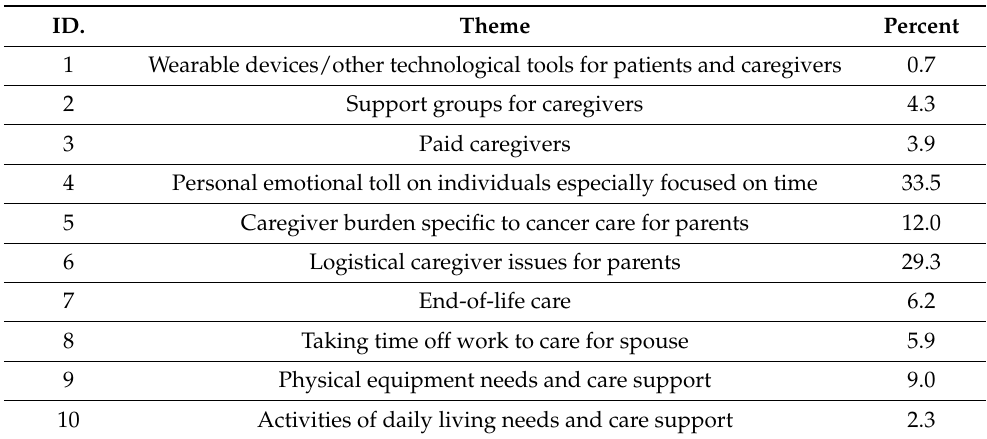
Table 1. Top ten themes found in the Reddit Submission-only corpus. The percent column provides the percent of the posts in the subreddit corpus covered by the topic.